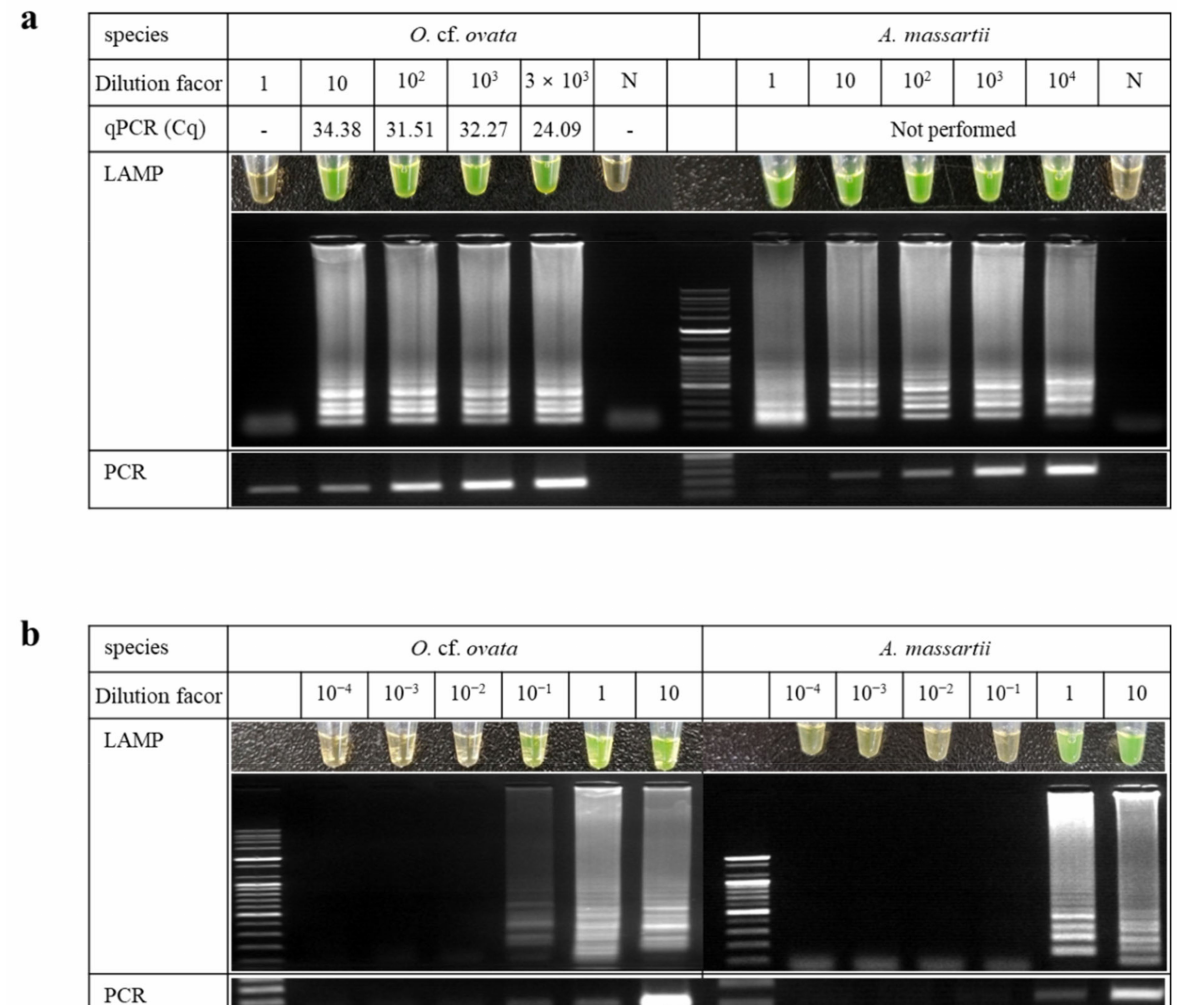
Figure 4. Comparison of the detection sensitivity with loop-mediated isothermal amplification (LAMP) and conventional PCR. ( a ) Samples in each line were serially diluted (from 3 × 10 3 cells in O . cf. ovata and 10 4 cells in A. massartii ) from genomic DNA which was extracted from the sample concentrated with GF/C filter. ( b ) Samples in each line were serially diluted from directly isolated ten cells without the column-based DNA extraction processing. cq = quantification